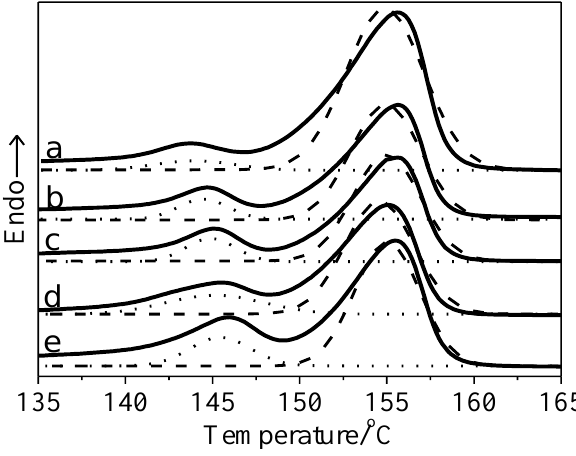
Figure 3. DSC curves of neat PLA and the PLA/thermoplastic starch/SiO 2 composite. The solid lines represent the experimental data, the dashed lines represent the fitting lines of the main melting peaks, and the dotted lines represent the fitting lines of the shoulder melting peaks. Curve a is for 10 parts, b is for 15 parts, c is for 20 parts, d is for 25 parts, and e is for 30 parts of thermoplastic starch.